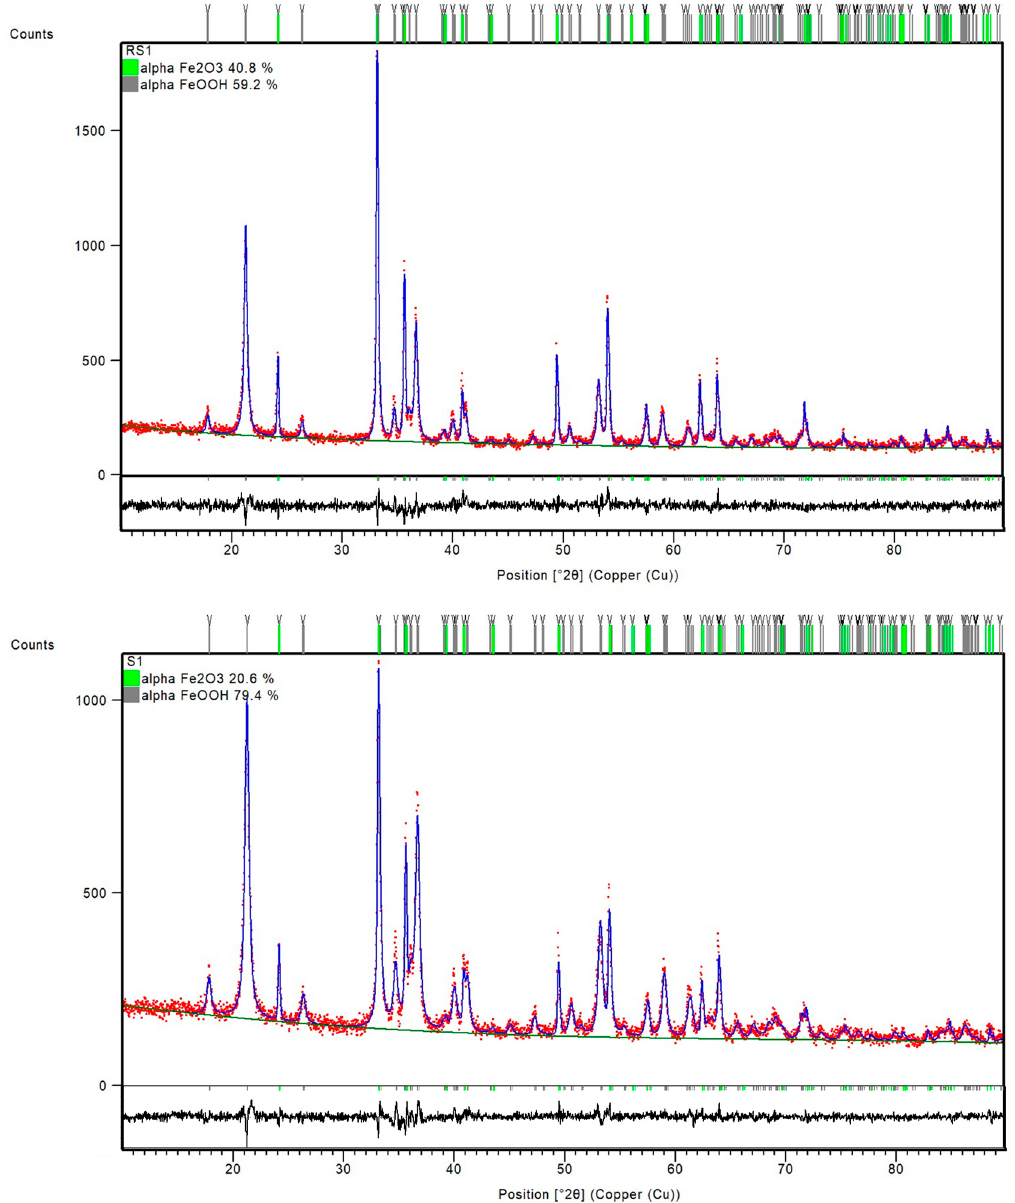
Figure 2. Final observed (red dots) and calculated (blue, solid lines) powder diffraction profiles for reference sample RS1 and sample S1 as obtained from the Rietveld refinement. The green and gray tick marks show the reflection positions of α -Fe 2 O 3 and α -FeOOH, respectively. The lower, black, solid lines show the difference profiles.